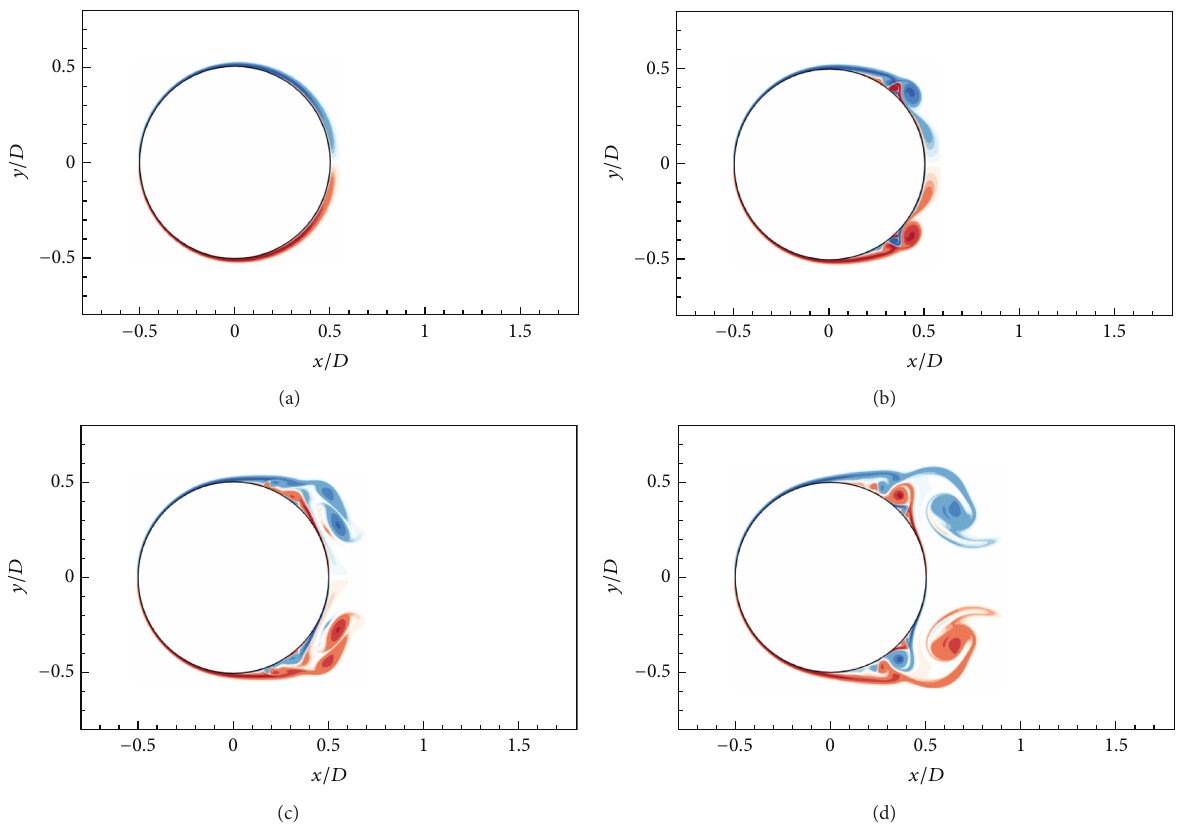
Figure 10: Instantaneous vorticity isocontours for an impulsively started circular cylinder at Re = 9500 : (a) 𝑇 = 1 , (b) 𝑇 = 2 , (c) 𝑇 = 3 , and (d) 𝑇 = 4 .